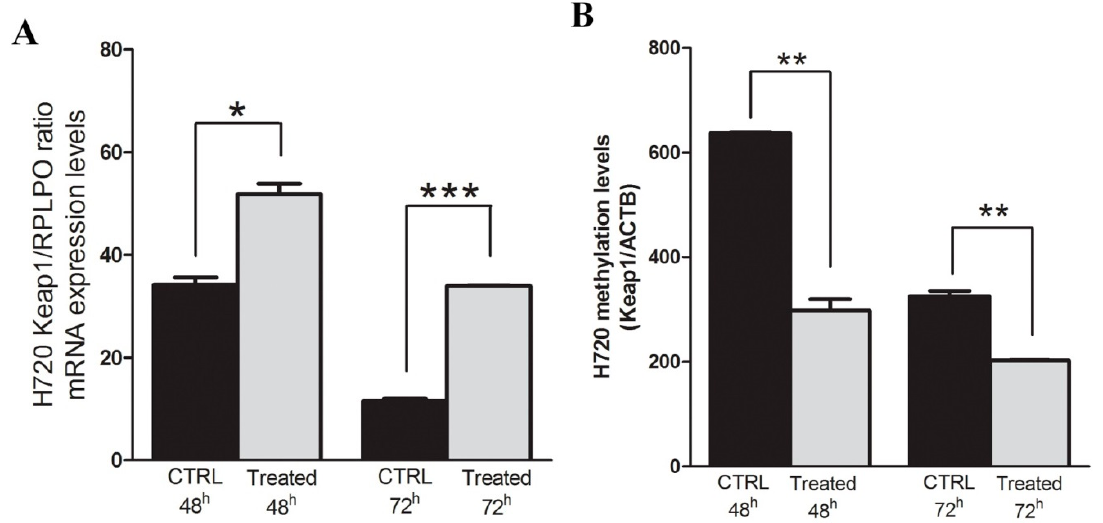
Figure 3. ( A ) Changes in KEAP1 mRNA transcript levels in the H720 cell line before (Untreated) and after treatment with 5-aza-dC at 24 h and 48h. Error bars indicate the standard deviation of three di ff erent experiments. * p < 0.01, t -test. ( B ) Changes in KEAP1 promoter methylation levels in the H720 cell line by quantitative methylation real-time PCR before (CTRL) and after treatment with 5-aza-dC at 48 and 72 h. Error bars indicate the standard deviation of three di ff erent experiments. * p < 0.05, t - test.